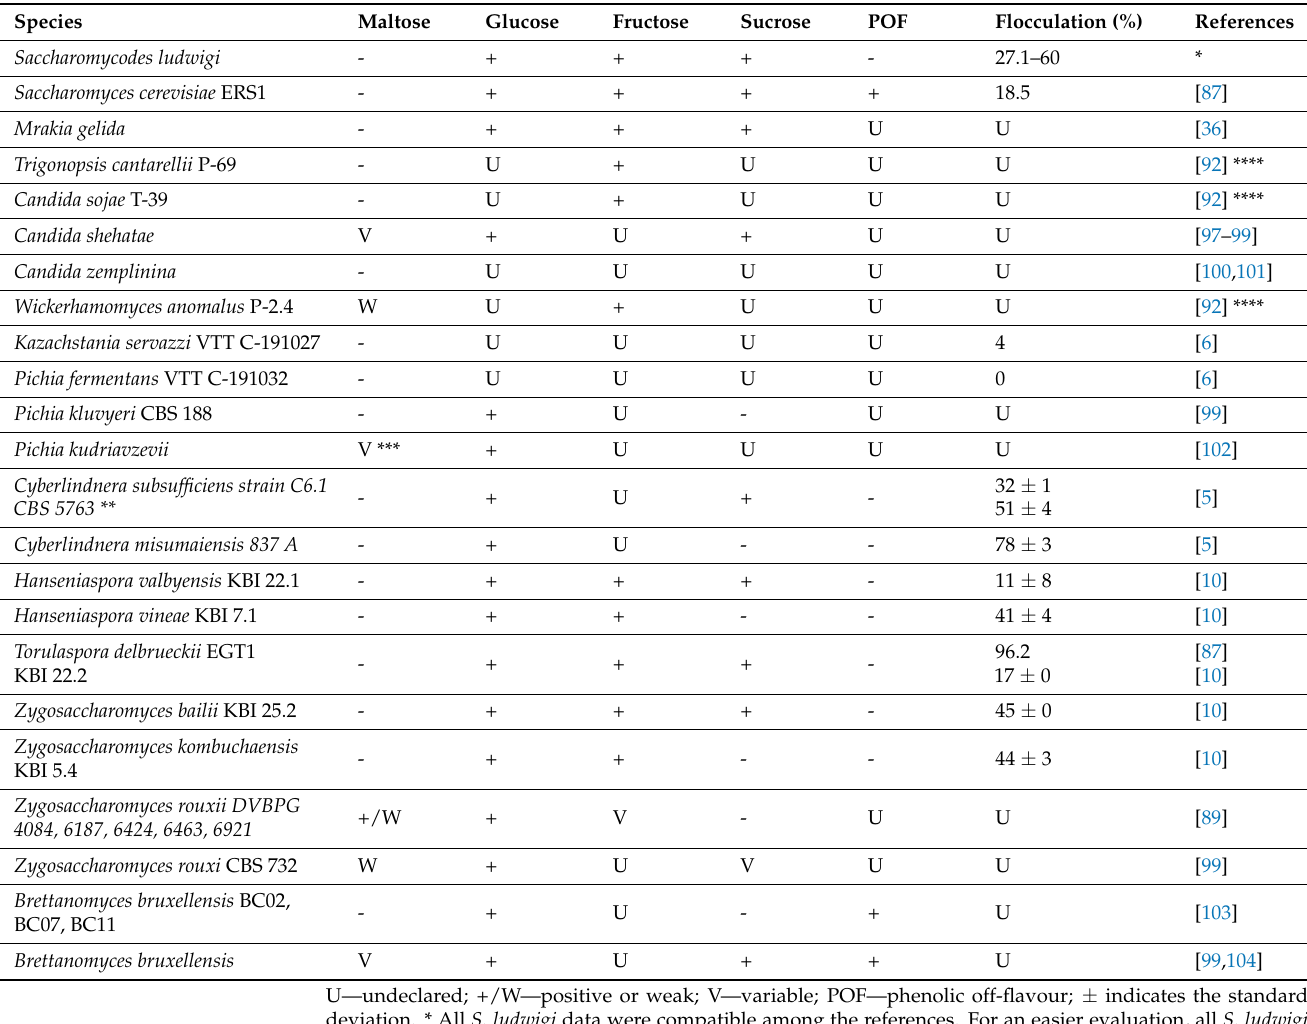
Table 1. Comparison of sugar consumption, POF production, and flocculation of selected yeast